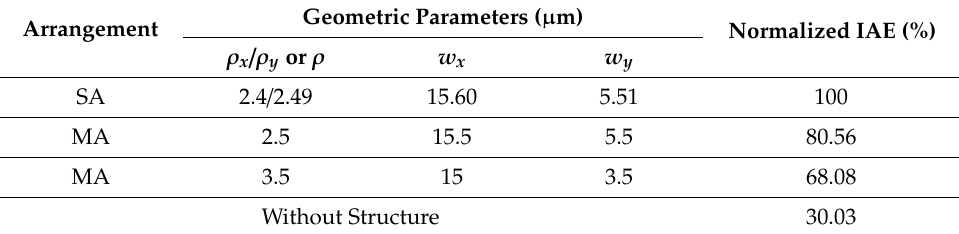
Figure 11. Normalized output voltages normalized by the maximum of test 2 case for three trial thermopiles. Table 4. Simulation results of the normalized IAE normalized by the maximum of them at target temperature 60 ◦ C for several thermopiles with SRHA of the given geometric parameters and without structure.